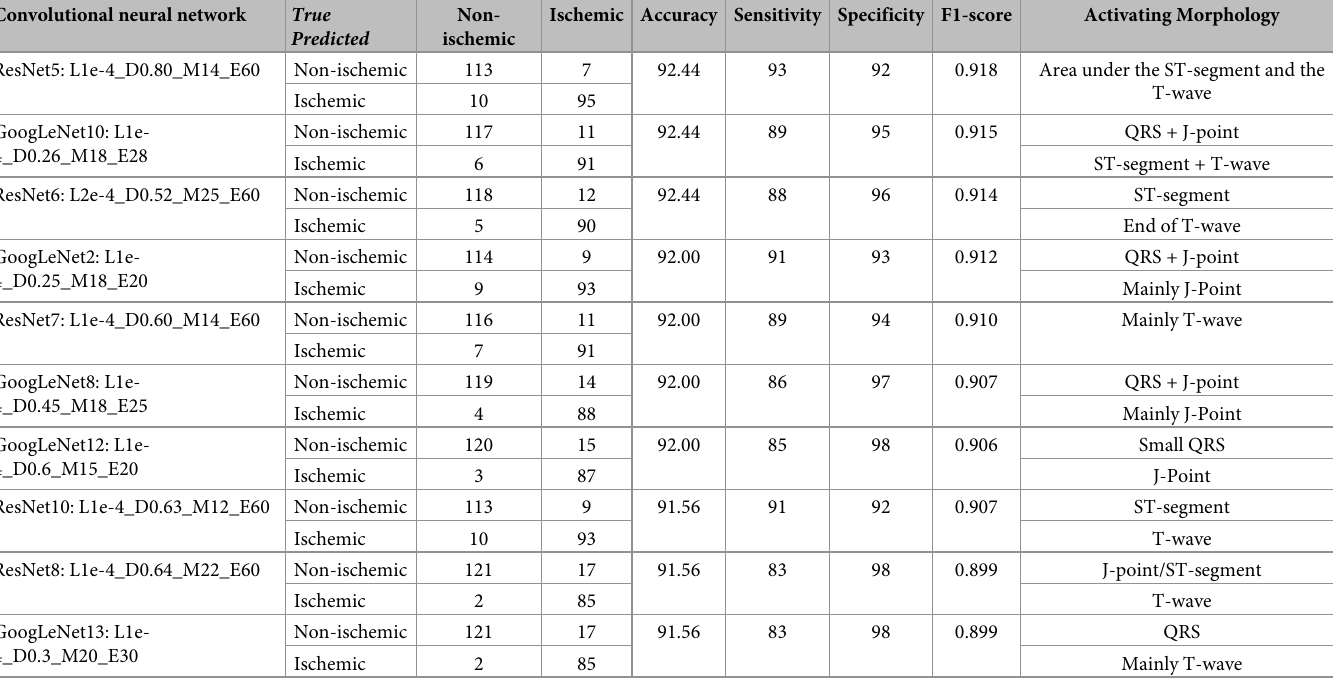
Table 3. Prediction and performance of the best ten trained networks. Convolutional neural